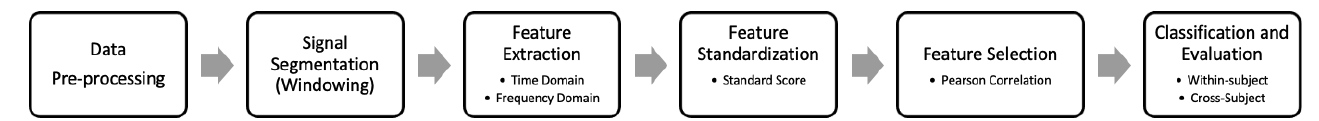
Playing table soccer, 1 vs. 1